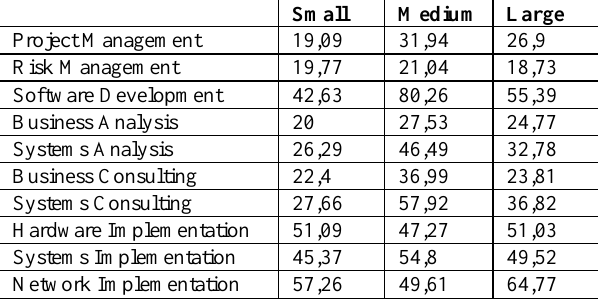
Table 4: The extent to which the different size of organisations outsource their ICT functions